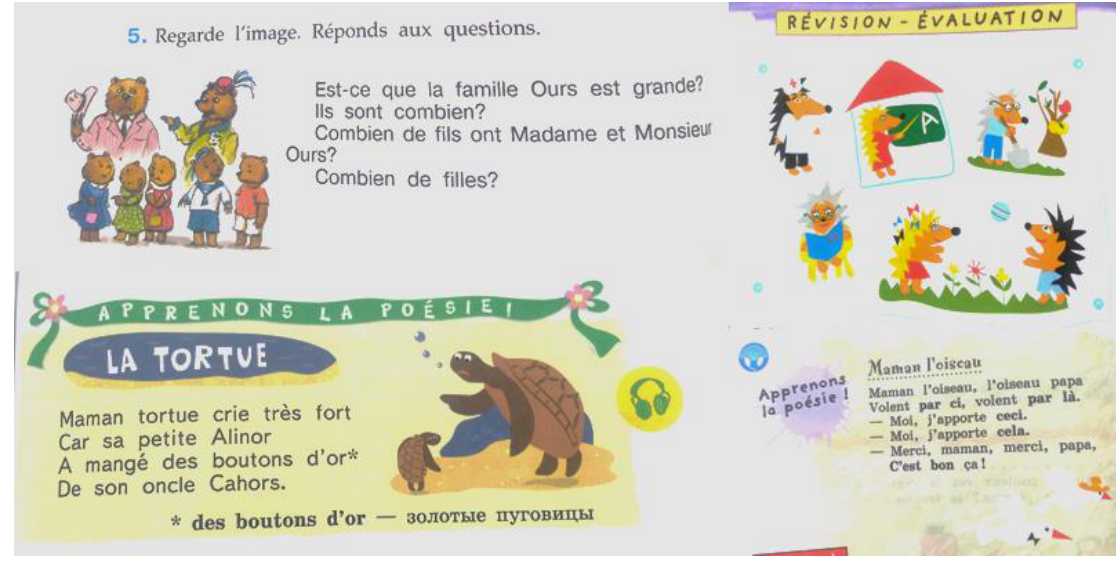
Fig. 1 Fairy-tale characters, representing family members in the French language textbooks To estimate the emotional-value constituent of these textbooks illustrations the following analysis components were carried